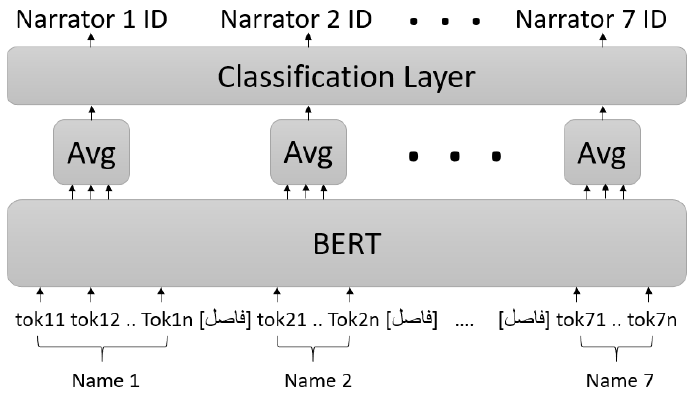
Figure 5. Classification process: At first every narrators’ name is tokenized. Next, the BERT model produces token embeddings. Token embeddings that belong to the same narrator are averaged. Finally, a classification layer produces the output Narrator IDs. Better seen after zooming